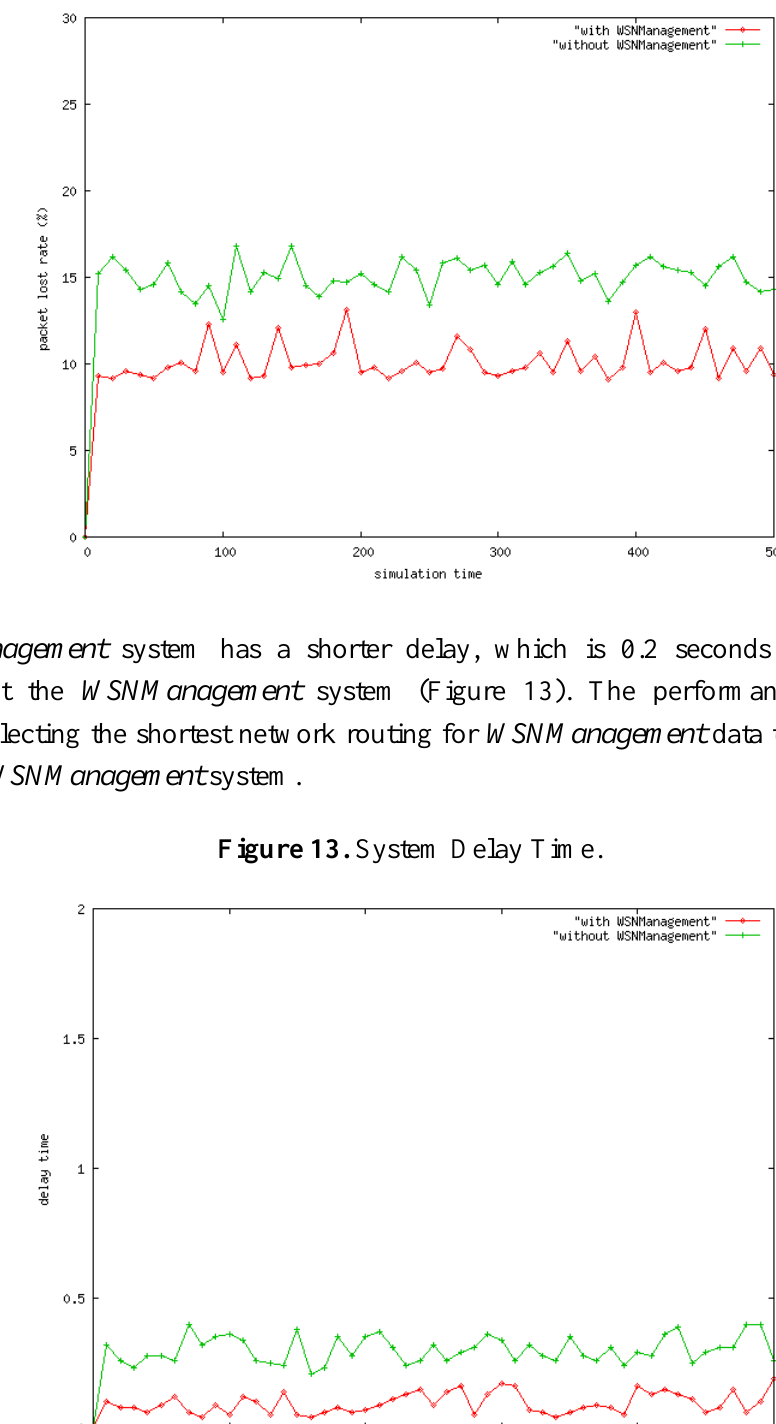
Figure 12. System Packet Loss Rate.